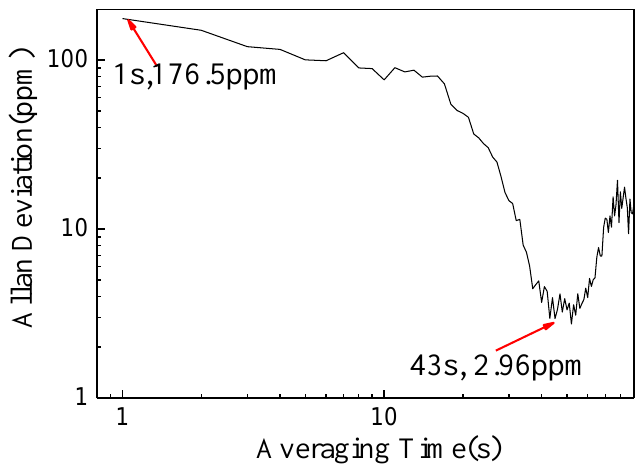
Figure 12. Allan variation plot as a function of averaging time.